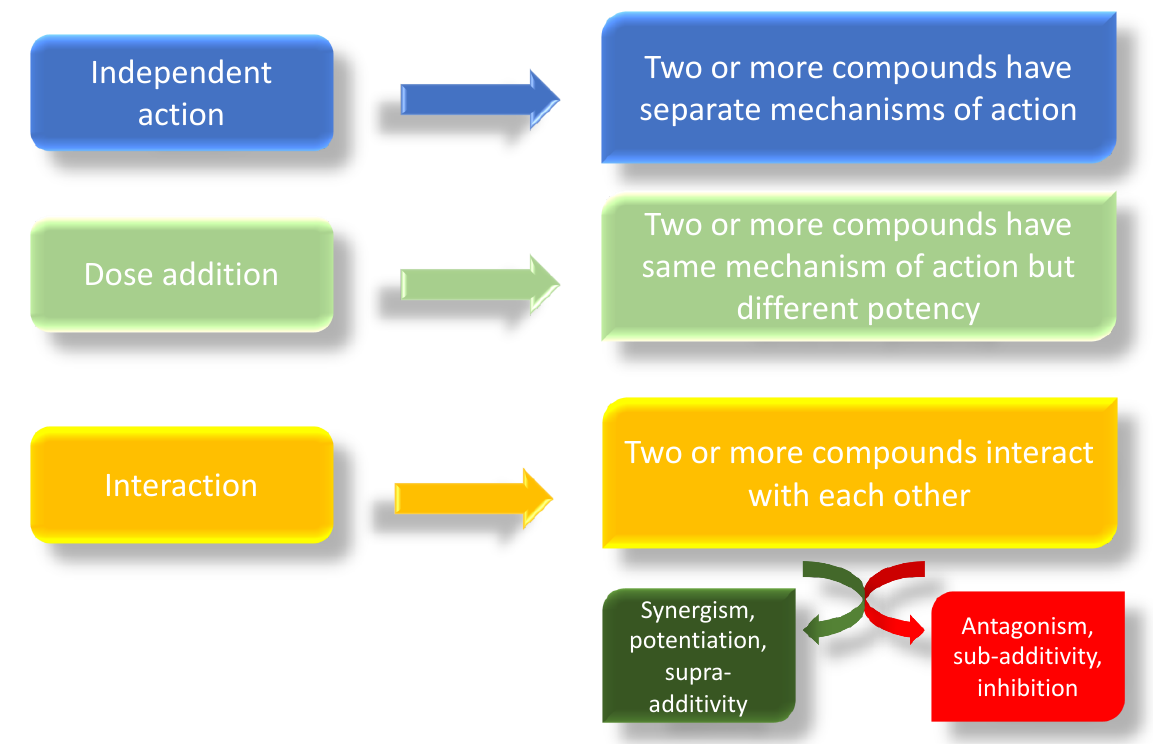
Figure 2. Possible mechanisms of action of combined exposure of different compounds.